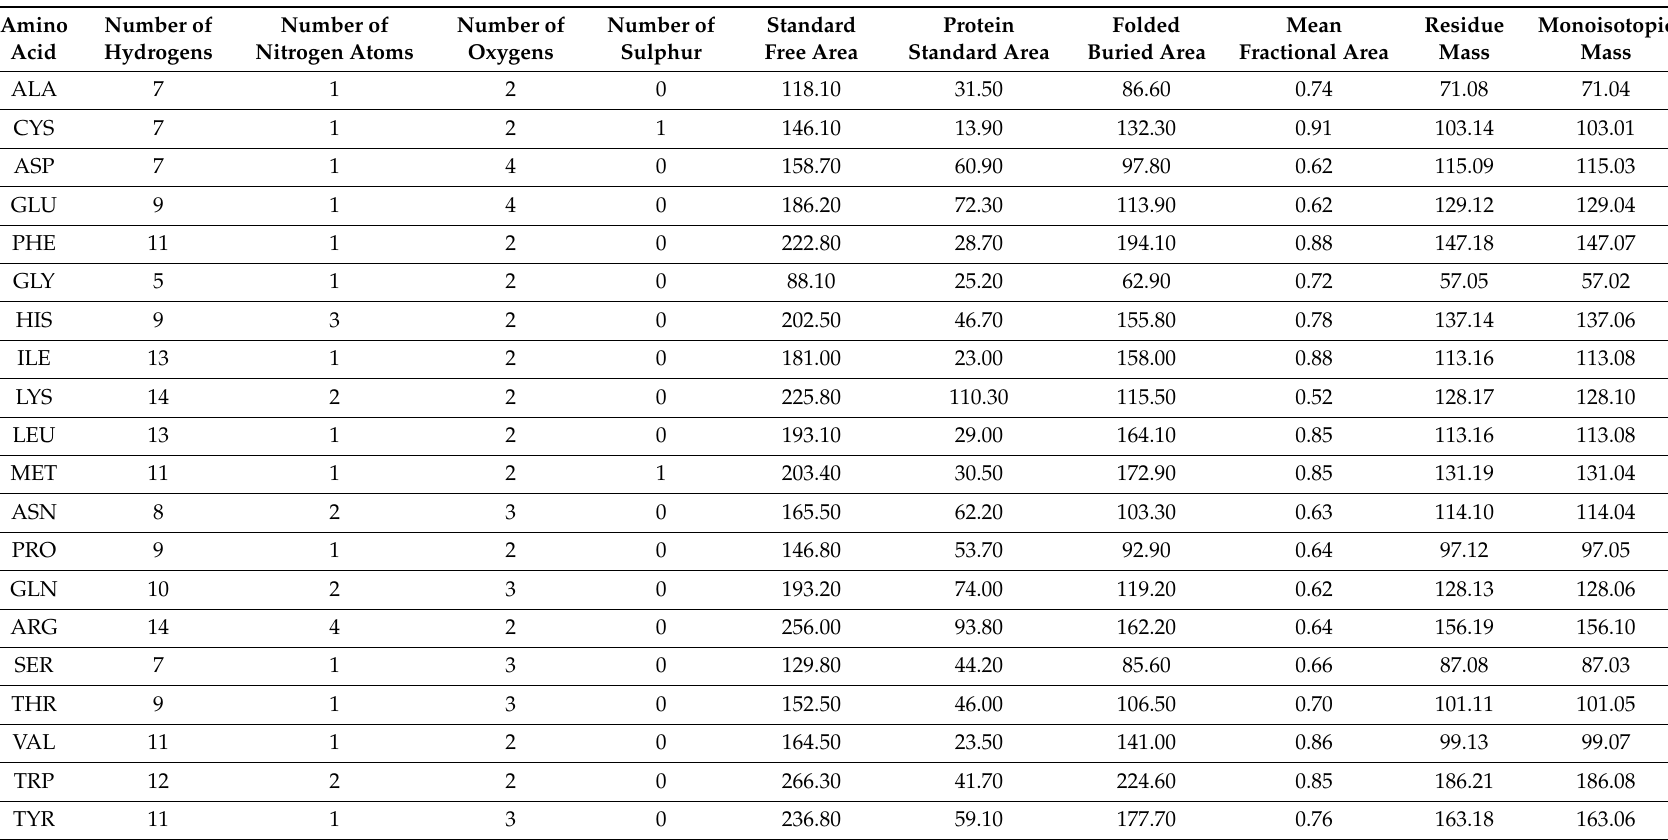
Table A5. Literature-based amino acid features, such as secondary structure propensity, pKa associated values, number of atoms of each type and standard area and mass associated values, attained from BioMagResBank